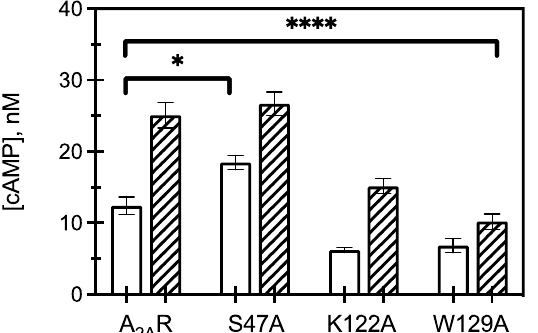
Figure 4. Downstream signaling of CCM variants. cAMP concentrations measured from HEK293 cells expressing A 2A R or an A 2A R variant (as listed) in the presence (hatched) and absence (open) of 1 µ M CGS21680 (a selective agonist for A 2A R). The bars represent the mean ± S.E.M. from n ≥ 3 independent experiments performed in triplicate. * p < 0.05 and **** p < 0.0001 are significantly different from A 2A R control for ligand activated CCM variants.